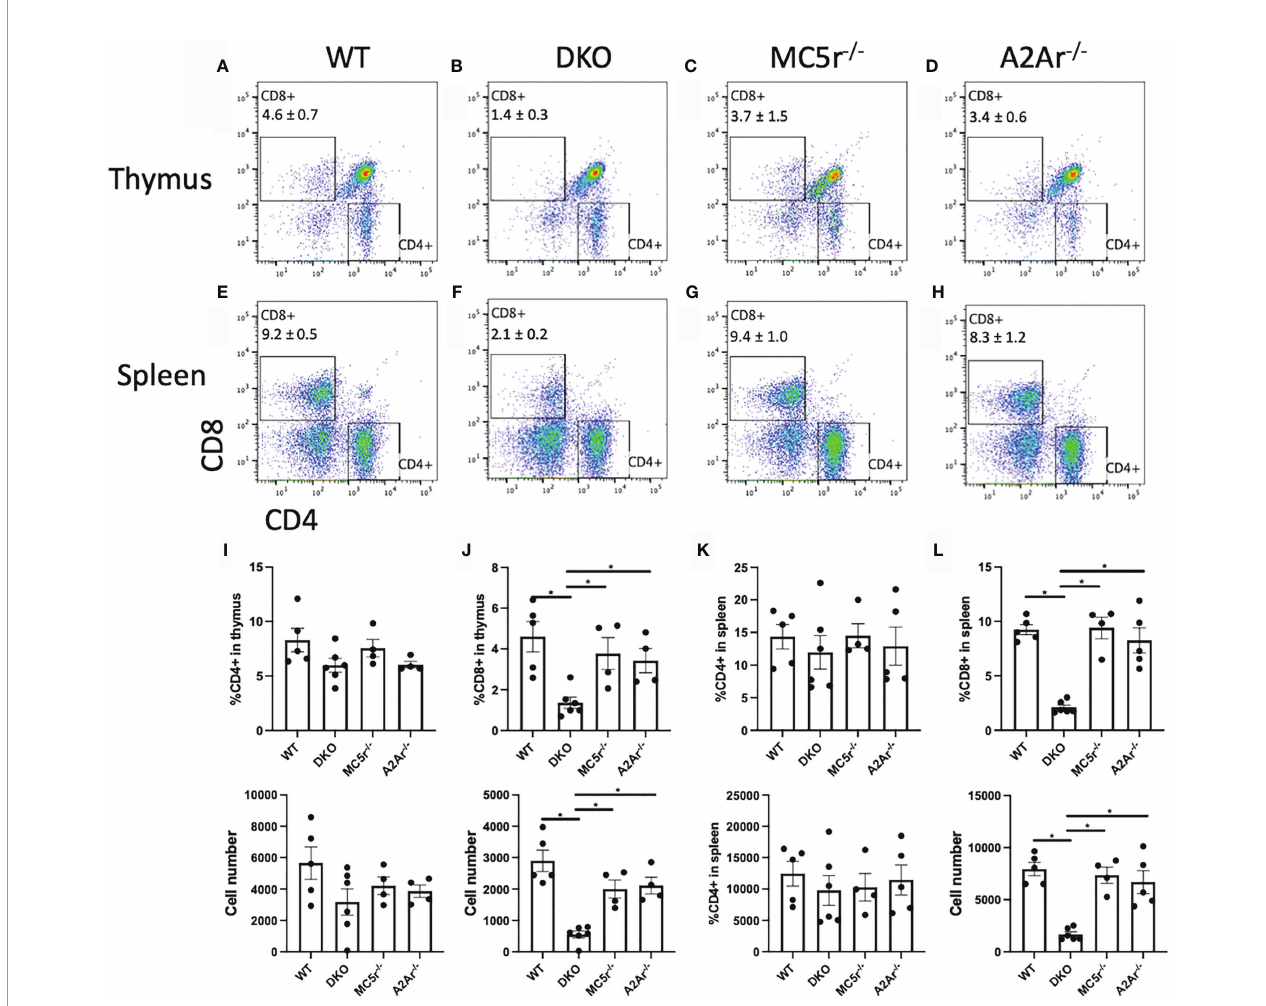
FIGURE 6 | Comparison of CD4 and CD8 T cells in WT, MC5r -/- , A2Ar -/- , and DKO mice. The spleens and thymus of naïve WT (n = 4-5), DKO (n = 6), MC5r -/- (n = 4) and A2Ar -/- (n = 4-5) mice were harvested and stained for CD8 and CD4. Representative pseudocolor fl ow cytometry dot plots are shown for CD8 and CD4 expression from the thymus (A – D) and spleen (E – H) with the mean ± SEM for all mice for thymic cells (I, J) and spleen cells (K, L) . Each experiment consisted of 1- 2 mice, and each experiment was repeated 2-3 times. Signi fi cance was assessed by nonparametric Mann-Whitney U test. Statistical signi fi cance (*P ≤ 0.05) is designated by